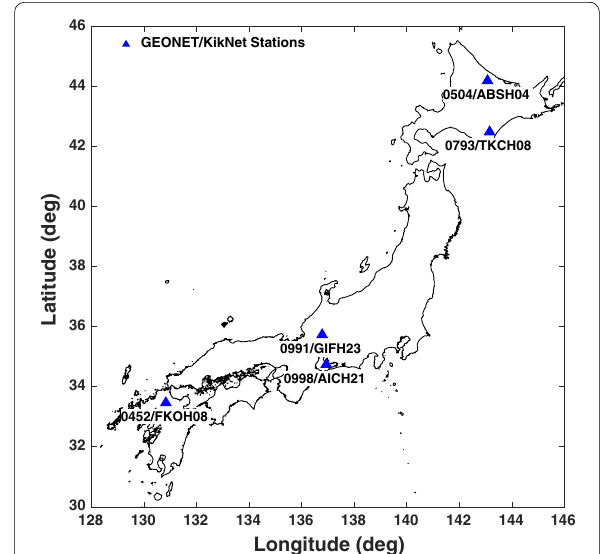
Fig. 6 The five almost collocated KiK-net and GEONET stations, with a horizontal distance of 5.7 m (AICH21, 0998), 7.4 m (GIFH23, 0991), 10.1 m (TKCH08, 0793), 11.4 m (ABSH04, 0504) and 24.4 m (FKOH08, 0452),